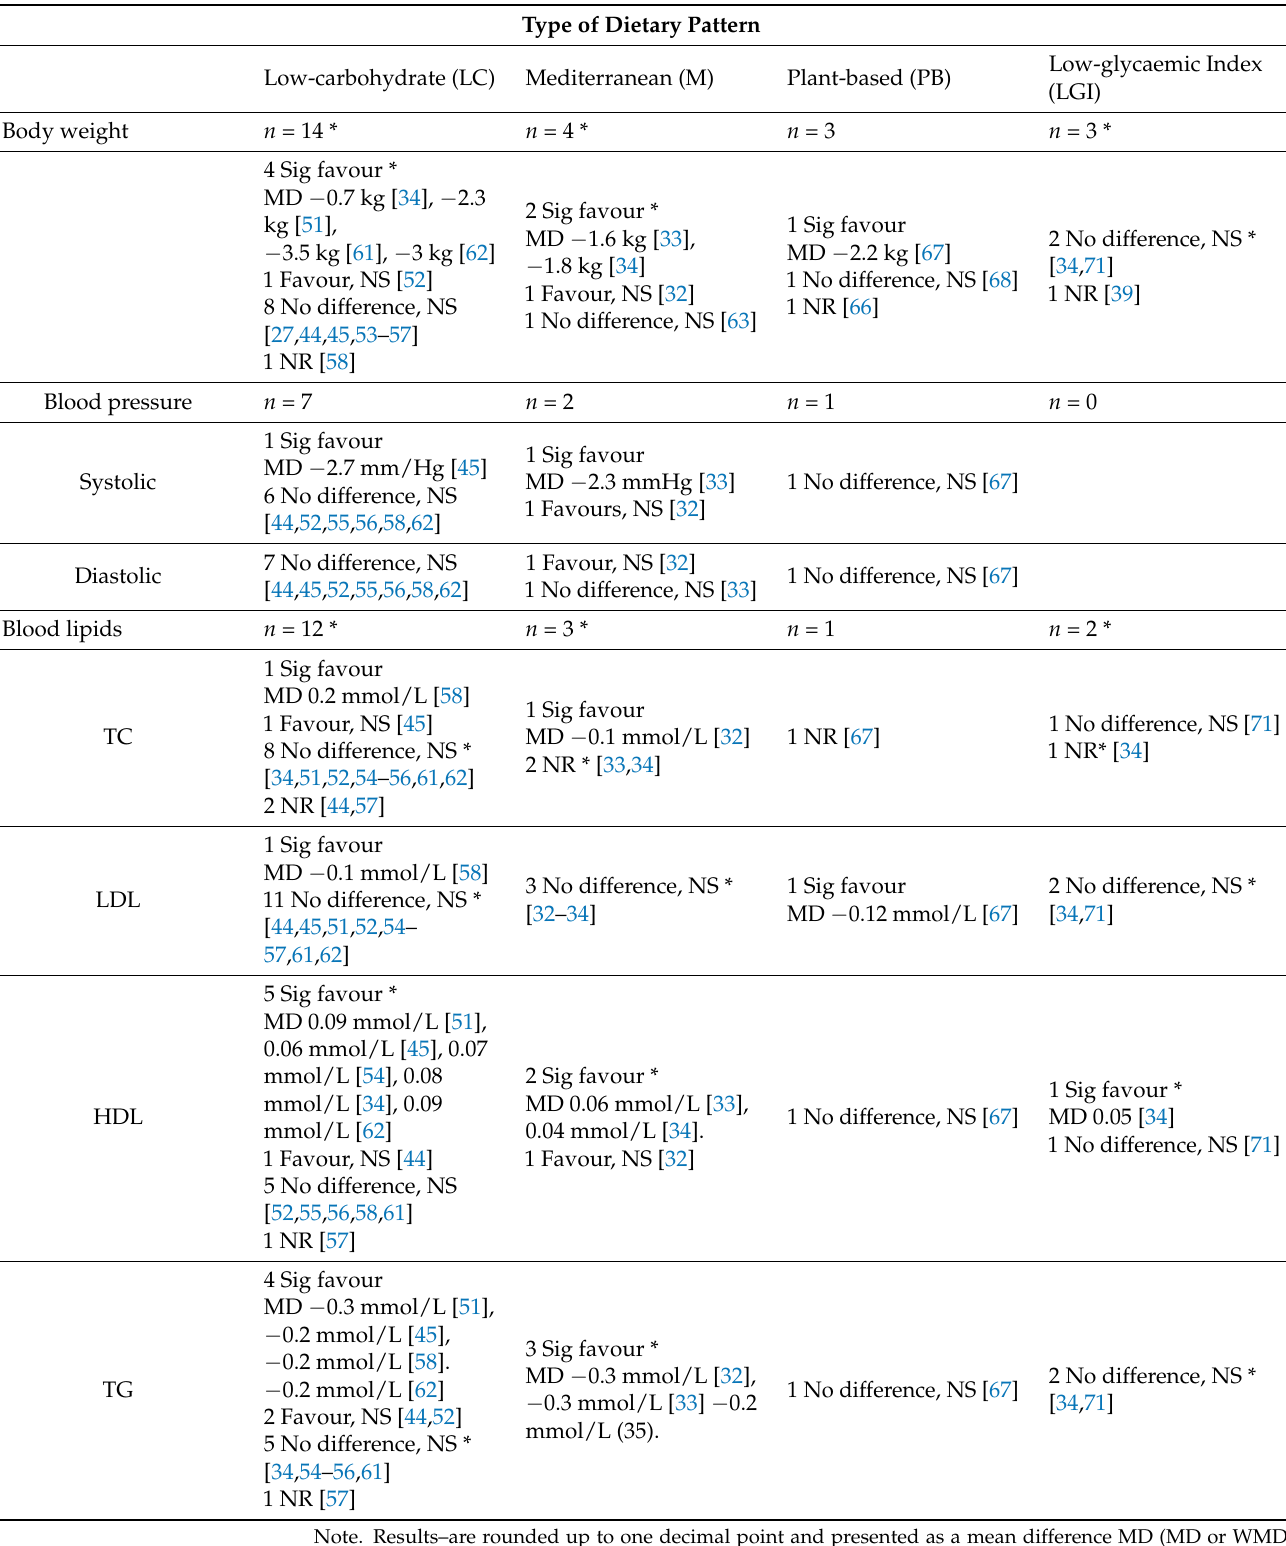
Table 5. Secondary outcomes from systematic reviews with meta-analysis in four dietary